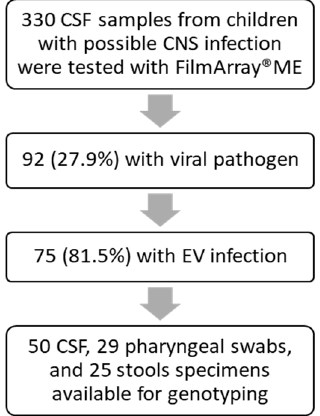
Figure 1. The workflow of available cerebrospinal fluid (CSF) samples from children with suspected meningitis/encephalitis that were included in this study.